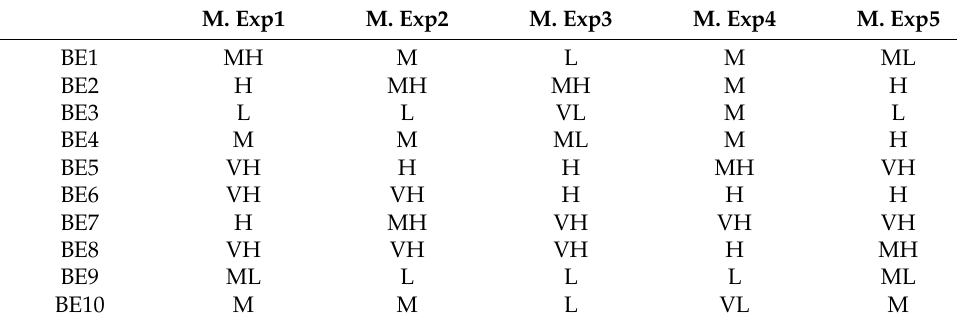
Table 6. Verbal assessment of each basic event.